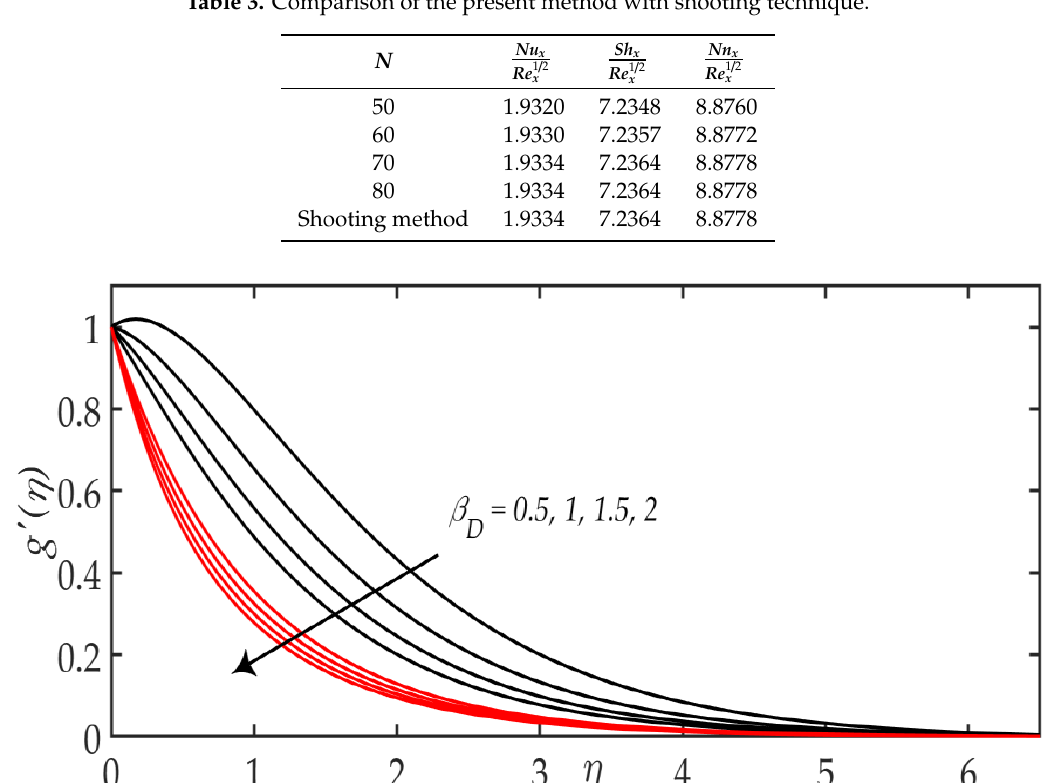
Figure 3. Variation of 𝑁 𝑟 and 𝐺 𝑟 𝑅 𝑒2 on velocity distribution. Black line: 𝐺 𝑟 𝑅 𝑒2 = 5.5 , Red line: 𝐺 𝑟 𝑅 𝑒2 = 10.5. Figure 4. Variation of 𝑅 𝑏 and 𝐺 𝑟 𝑅 𝑒2 on velocity distribution. Black line: 𝐺 𝑟 𝑅 𝑒2 = 5.5 , Red line: 𝐺 𝑟 𝑅 𝑒2 = 10.5. The influence of Prandtl number 𝑃 𝑟 , Hartmann number 𝑀 , the Brownian-motion parameter 𝑁 𝑏 , the thermophoresis parameter 𝑁 𝑡 , local Eckert number 𝐸 𝑐 , for various numeric values are drawn through Figures 5 – 7. From Figure 5, it is determined that by taking an increment in Prandtl number 𝑃 𝑟 , the temperature distribution slows down, although by enhancing the Hartmann number 𝑀, it accelerates the temperature distribution. Figure 6 is adorned for the effect of thermophoresis parameter 𝑁 𝑡 and the Brownian-motion parameter 𝑁 𝑏 of the temperature distribution, and also notice that the temperature distribution boosts for both parameters by enhancing the numeric value